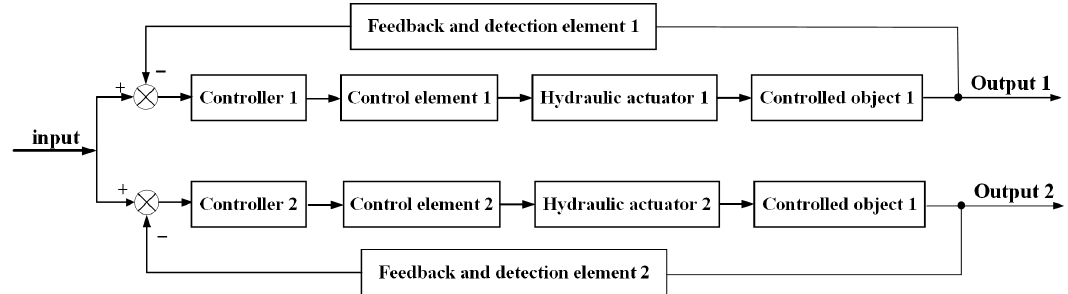
Figure 2. Equivalent control block diagram of hydraulic synchronous control system.